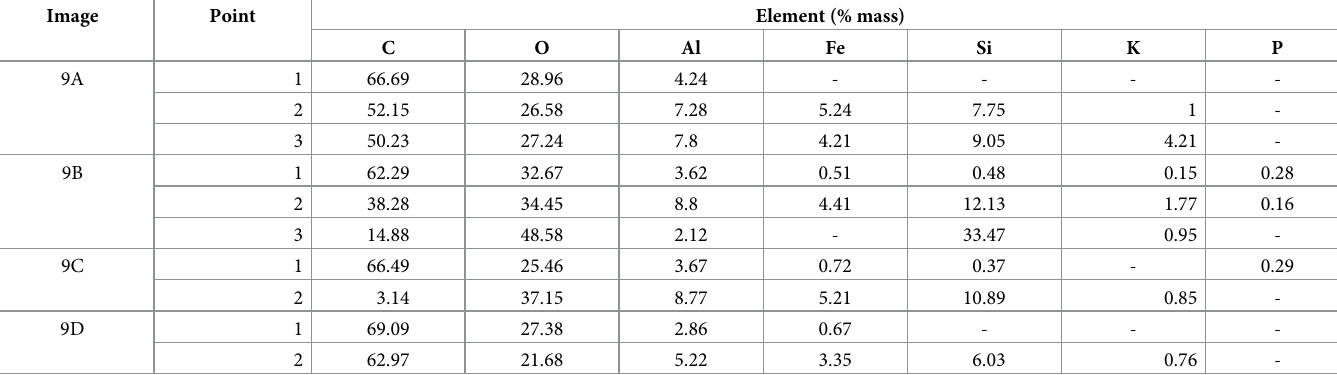
Table 3. Microanalysis points observed by EDS and indicated in Fig 9A, 9B, 9C and 9D. Image